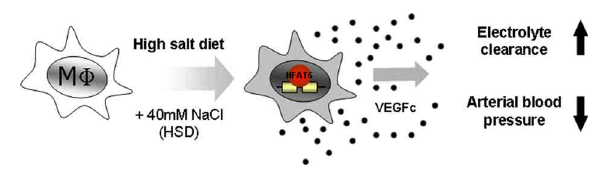
FIGURE 2 | Macrophages act as local sensors and regulators of electrolyte composition in the skin interstitium. Macrophages are attracted to tissues with high concentrations of salt. Under these conditions NFAT5 is activated in macrophages. NFAT5 then drives the expression of vascular endothelial growth factor C (VEGFc), resulting in the hyperplasia of skin lymph capillaries. This results in the clearance of electrolytes from the skin and subsequently a reduction in blood